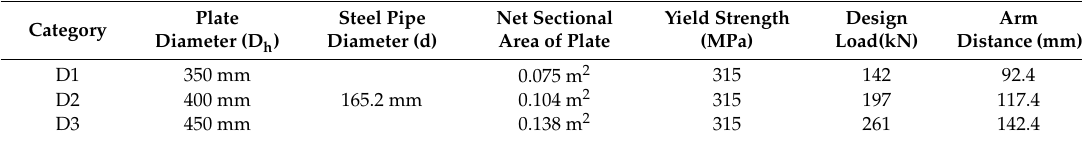
Table 1. Specifications and design load of the helix plate.